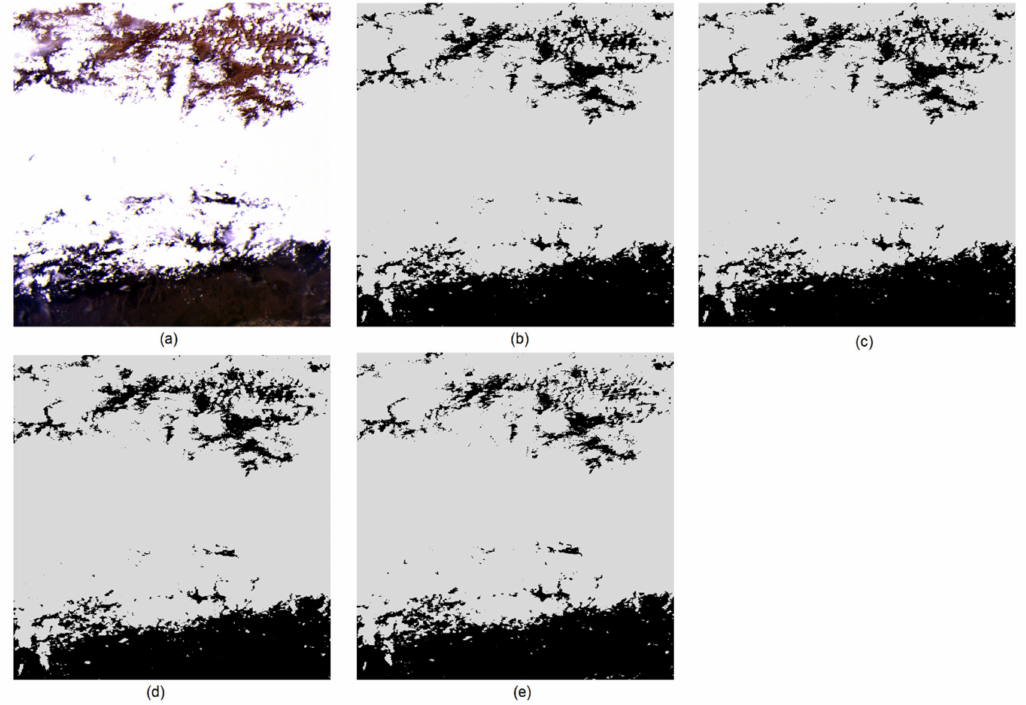
Figure 13. A part of the original GF-4 imagery ( a ) and the cloud-detection results of SVM with di ff erent